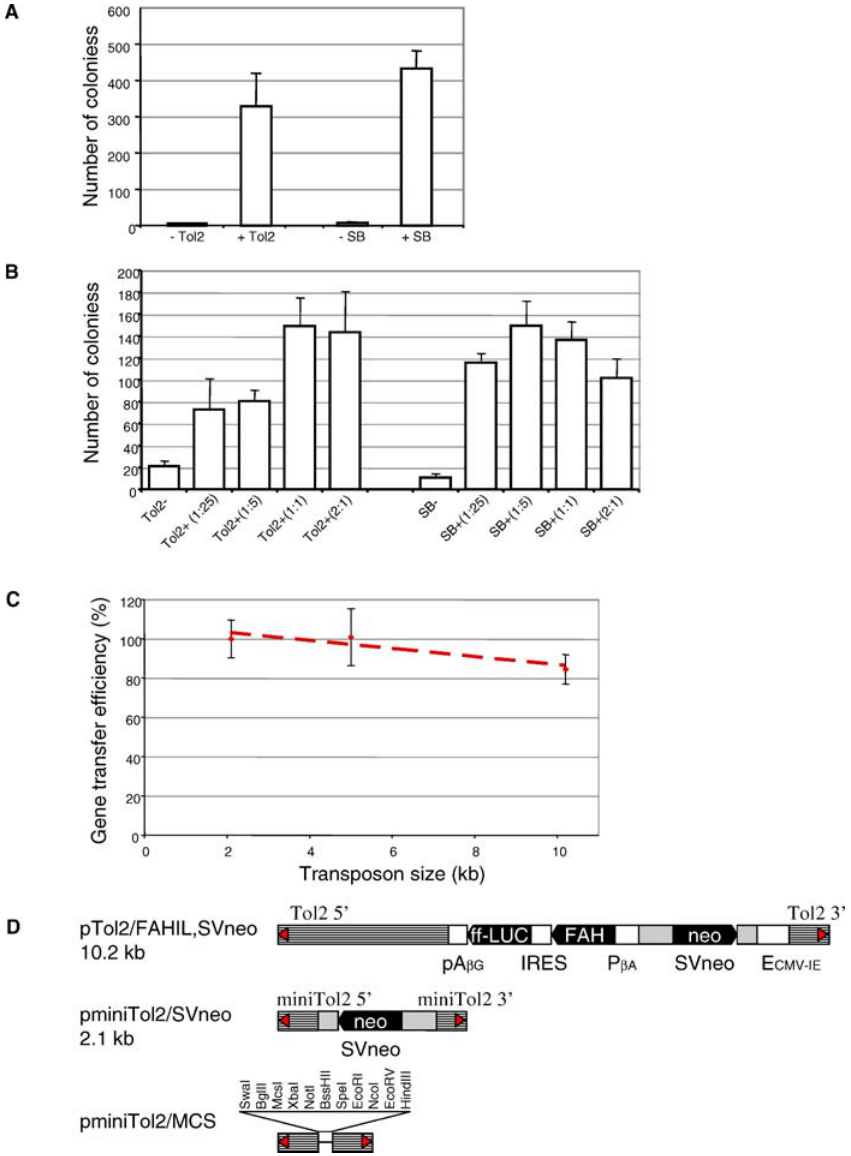
Figure 2. Large Cargo-Capacity, Tol2 -mediated Transposition in Human Cells (A) Comparison of Tol2 and SB transposons in G418-resistant colony-forming assay in HeLa cells. SB (pT2/SVneo) and Tol2 (pTol2/SVneo) transposons with corresponding transposase-coding plasmids (pCMV-SB10 or pCMV-Tol2) were transfected into HeLa cells under conditions optimized for SB [8]. Transposon plasmid amounts were adjusted to be in equal molar ratio to 500 ng of pT2/SVNeo and the transposase construct amounts were based on 500 ng of pCMV-SB10. For negative control, a CMV-driven GFP plasmid (pGL-1) was used instead of transposase. Three independent preparations of each transposon plasmid were used in each experiment. (B) Tol2 -mediated gene transfer activity is a positive function of Tol2 transposase activity. SB (pT2/SVneo [8]) and Tol2 (pTol2/SVneo depicted below the graph) transposons were transfected into HT1080 cells at various ratios of transposon to transposase (pCMV-SB10 [8] and pCMV-Tol2, respectively). For control experiments, pCMV-GFP plasmid was used. Total number of G418-resistant colonies per plate is plotted on the y -axis with error bars representing standard error of the mean of three transfection plates. In the transposon depiction below the graph, Tol2 sequences are shown as striped boxes with terminal inverted repeats indicated by red triangles. (C) Tol2 gene transfer efficiencies as a function of cargo-capacity. x -axis, transposon size in kilobases; y -axis, relative efficiency. Tol2 transposons of different sizes (2.1 kb, miniTol2/SVneo; 5.0 kb, Tol2/SVneo; 10.2 kb, Tol2/SVneo,FAHIL; two of them depicted below the graph) were transfected into HT1080 cells and selected for G418 resistance. The number of colonies obtained using each transposon was determined, and relative efficiency was calculated as percentage activity compared to miniTol2/SVneo 6 standard error ( n ¼ 3). Red line represents a linear interpolation of activity as a function of Tol2 transposon size. (D) Tol2 transposon constructs. Top, pTol2/FAHIL,SVneo. ECMV-IE is CMV immediate-early enhancer (open box), P b G is the chicken beta globin promoter (open box), pA b G is rabbit beta globin polyA, and IRES is encephalomyocarditis virus internal ribosome entry site (open box). Middle, pminiTol2/SVneo. Bottom depiction, miniTol2 vector with multiple cloning site (MCS) designed to facilitate use of this vector by the genetics community.